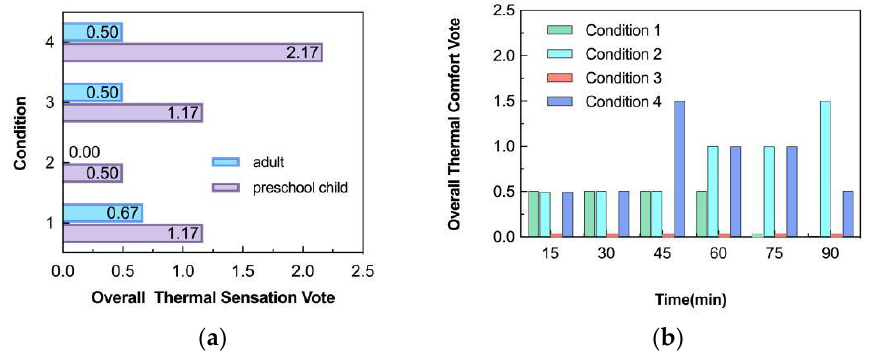
Figure 9. Comparison of the OTSV and OTCV in two groups of participants: ( a ) OTSV; ( b ) OTCV.